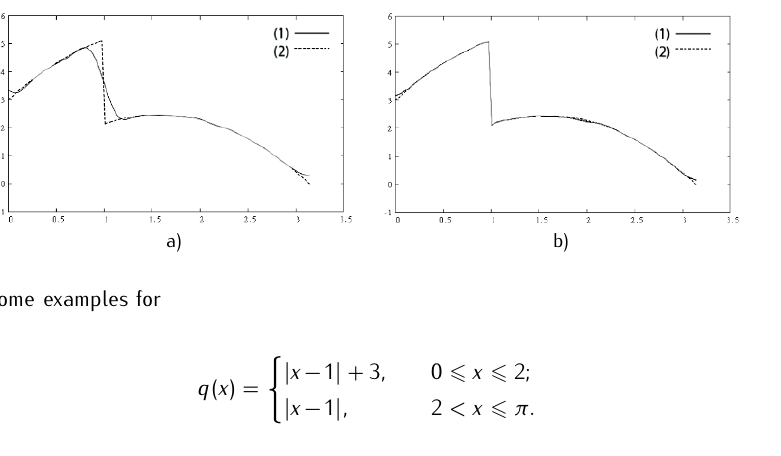
Figure 2. Line (1): reconstruction of potential p